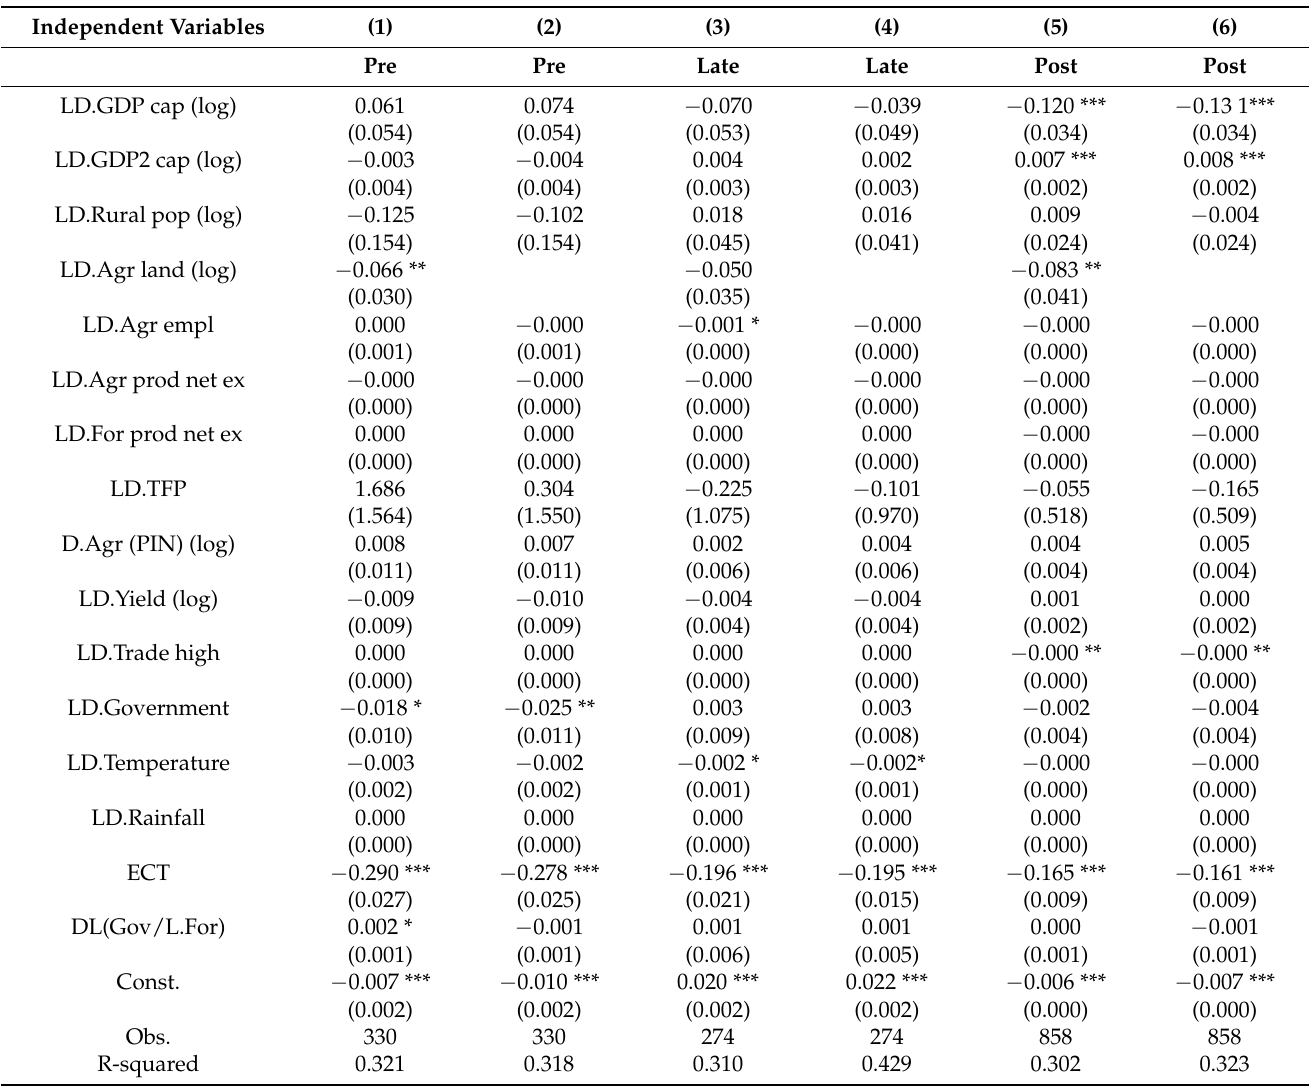
Table 7. Short-run equations, forest transition